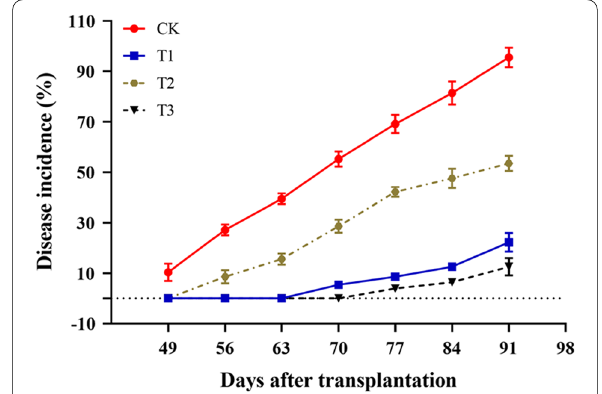
Fig. 7 Effect of biocontrol agent WS-10 on the disease incidence in a greenhouse experiment. Significance differences among the treatments are shown according to Duncan’s multiple range test ( P < 0.05) after particular days of transplantation